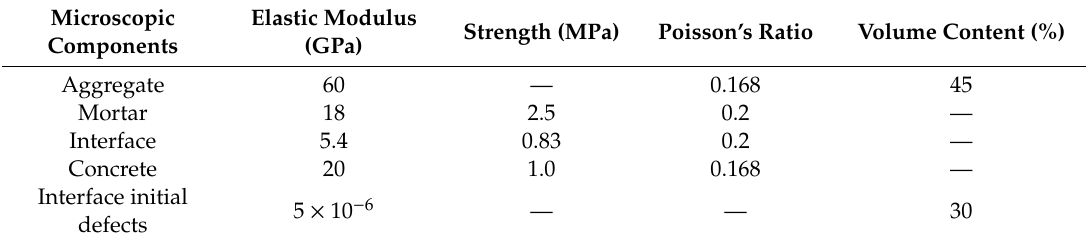
Table 1. Properties of primary materials.